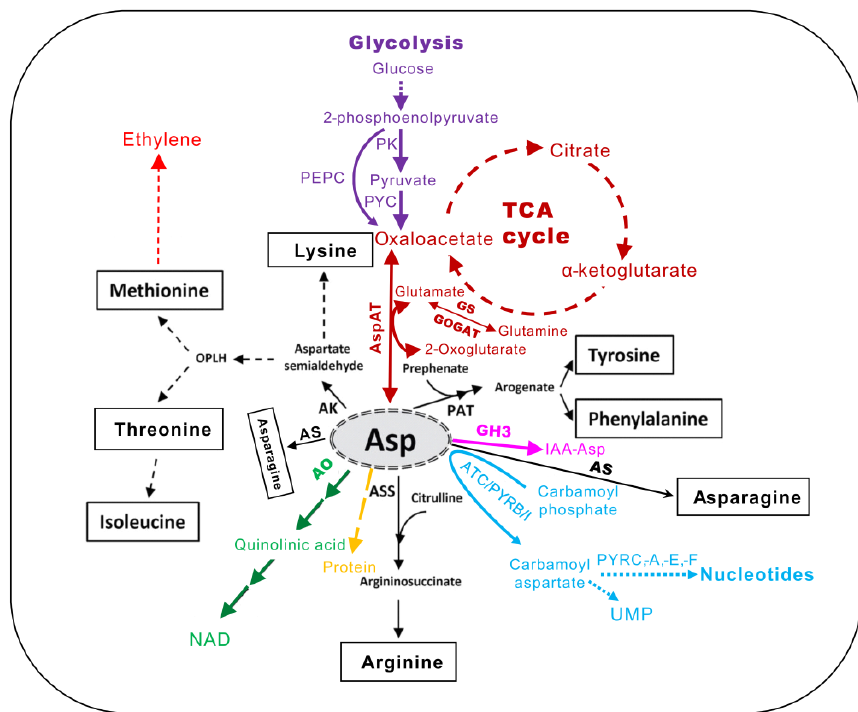
Figure 1. The central metabolic intermediates derived from L -aspartate (Asp) in plants (adapted from [5]). AK, aspartate kinase; AO, aspartate oxidase; ASS, argininosuccinate synthase; AS, asparagine synthase; PAT, prephenate aminotransferase; AspAT, aspartate aminotransferase; GS, glutamine synthetase; GOGAT, glutamine oxoglutarate aminotransferase; TCA, tricarboxylic acid cycle; NAD, nicotinamide adenine dinucleotide; PK, pyruvate kinase; PYC, pyruvate carboxylase;